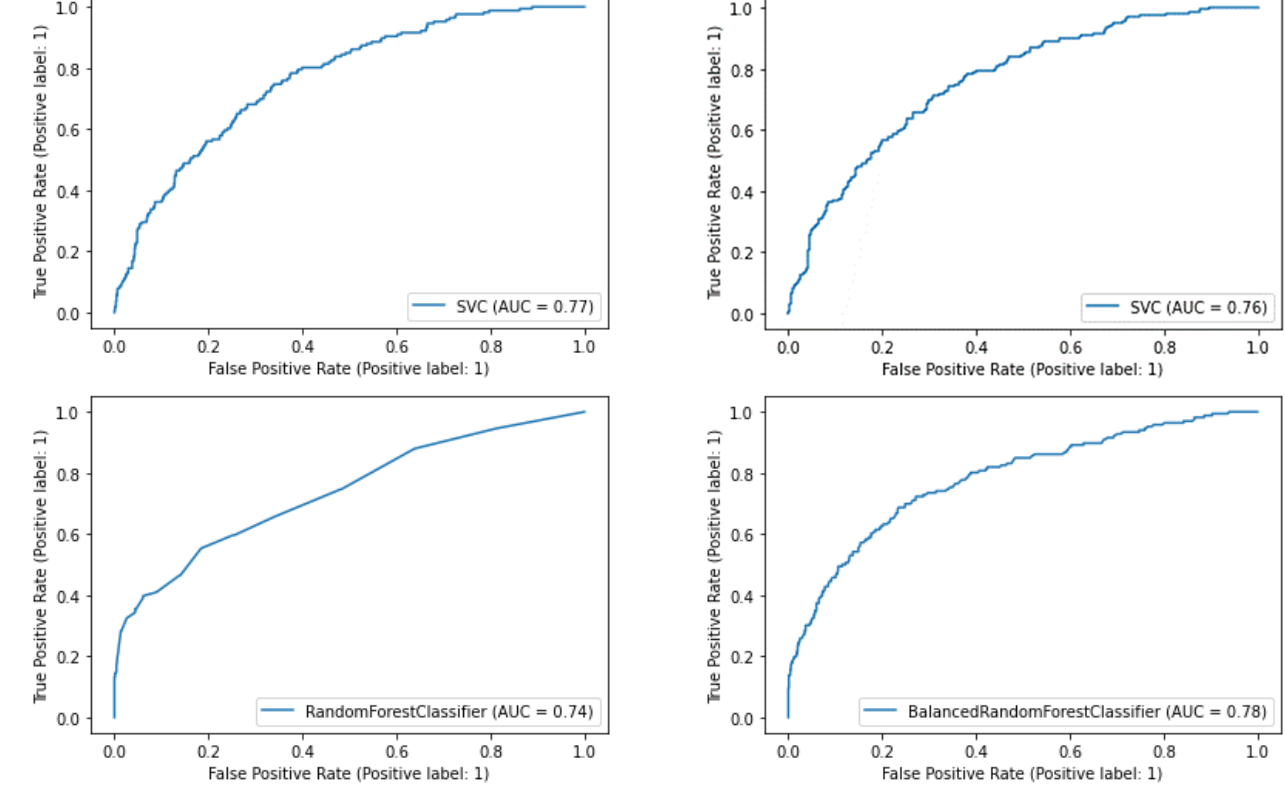
Figure 5. Classification performance measurement (AUC).